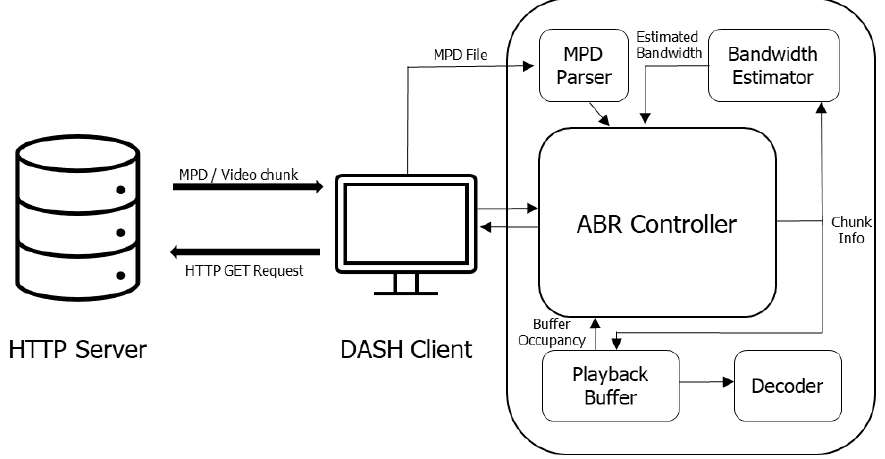
Figure 1. Structure of DASH-based HTTP Adaptive Streaming.